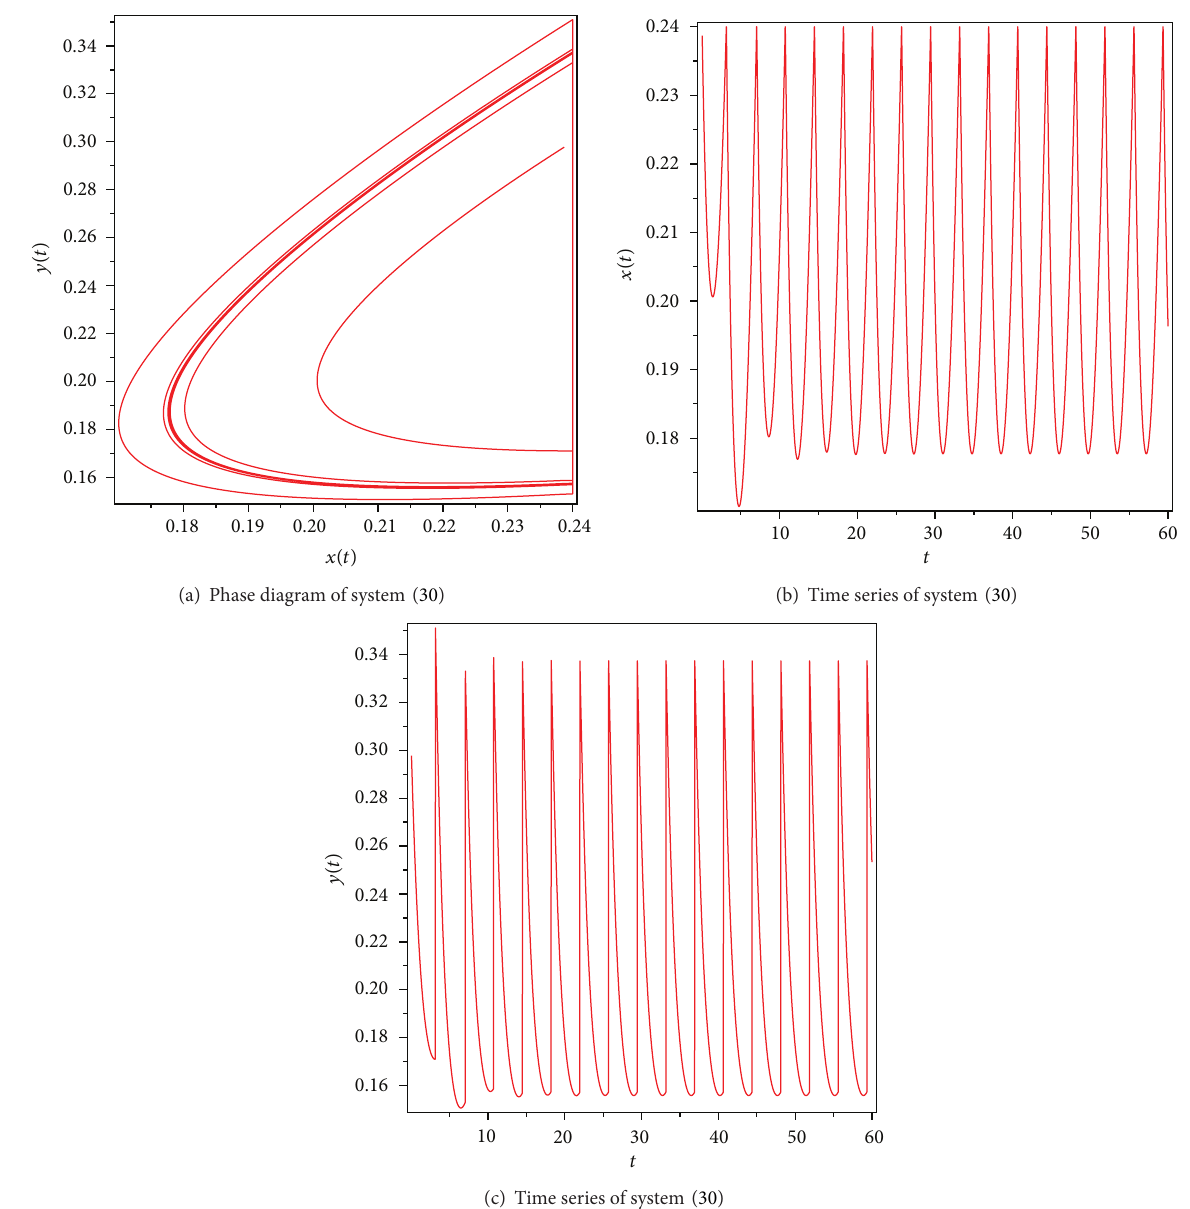
Figure 7: The periodic solution corresponding to Figure